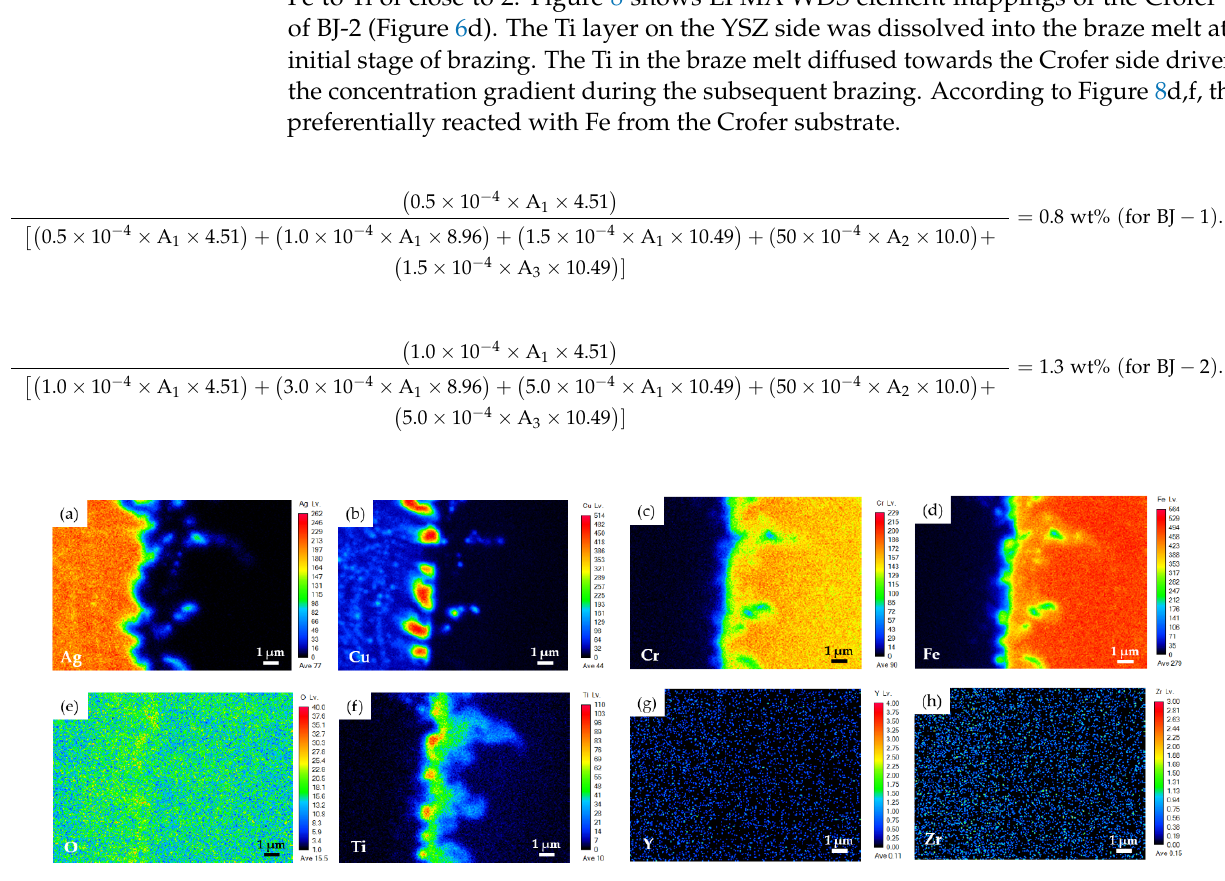
Figure 7. EPMA WDS element mappings of YSZ side in Figure 6c: ( a ) Ag, ( b ) Cu, ( c ) Cr, ( d ) Fe, ( e ) O, ( f ) Ti, ( g ) Y, and ( h ) Zr.